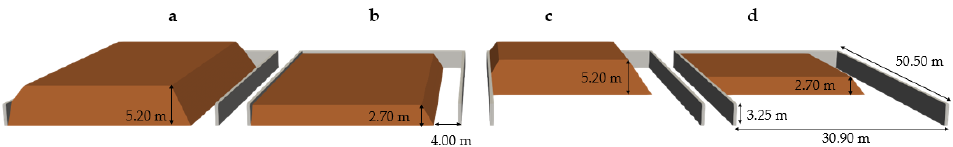
Figure 4. Sketch of the heap and analyzed configurations: high rectangular pile (HR, plot a ), low rectangular pile (LR, plot b ), high square pile (HS, plot c ), and low square pile (LS, plot d ).